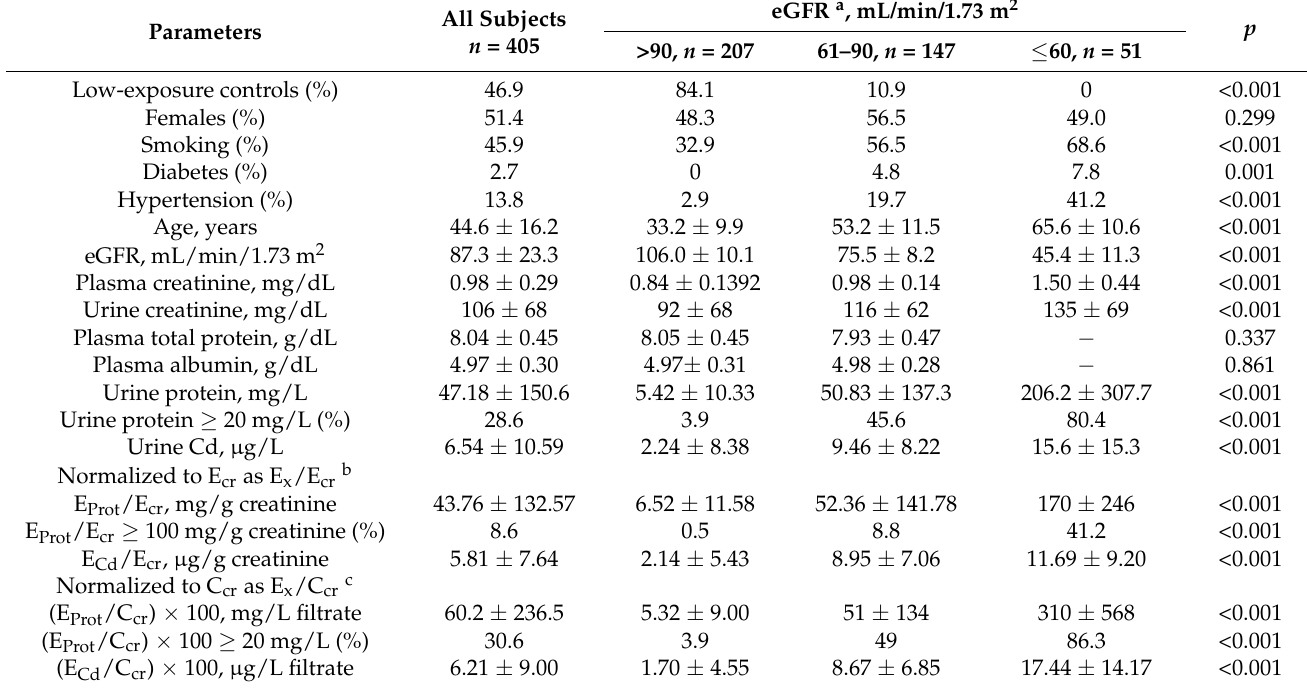
Table 1. Descriptive characteristics of the study subjects according to eGFR